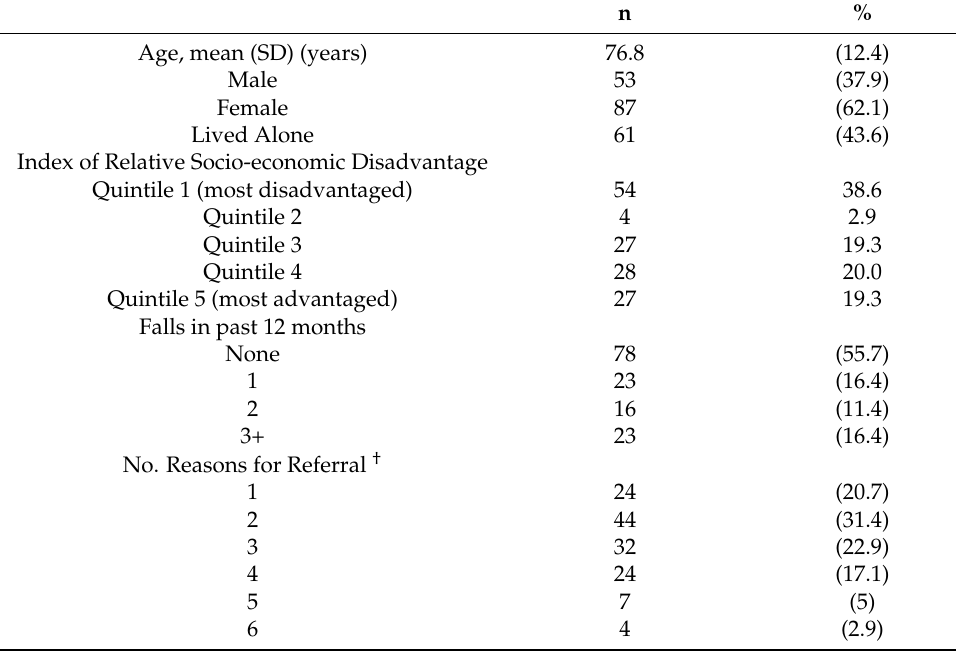
Table 1. Participant characteristics at baseline (n =